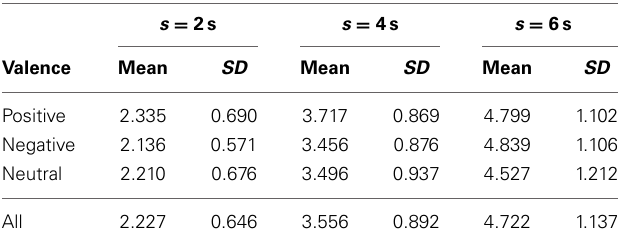
Table 2 | Statistics of reproduced durations (grand means and standard deviations) sorted by emotional valence and encoded duration s .